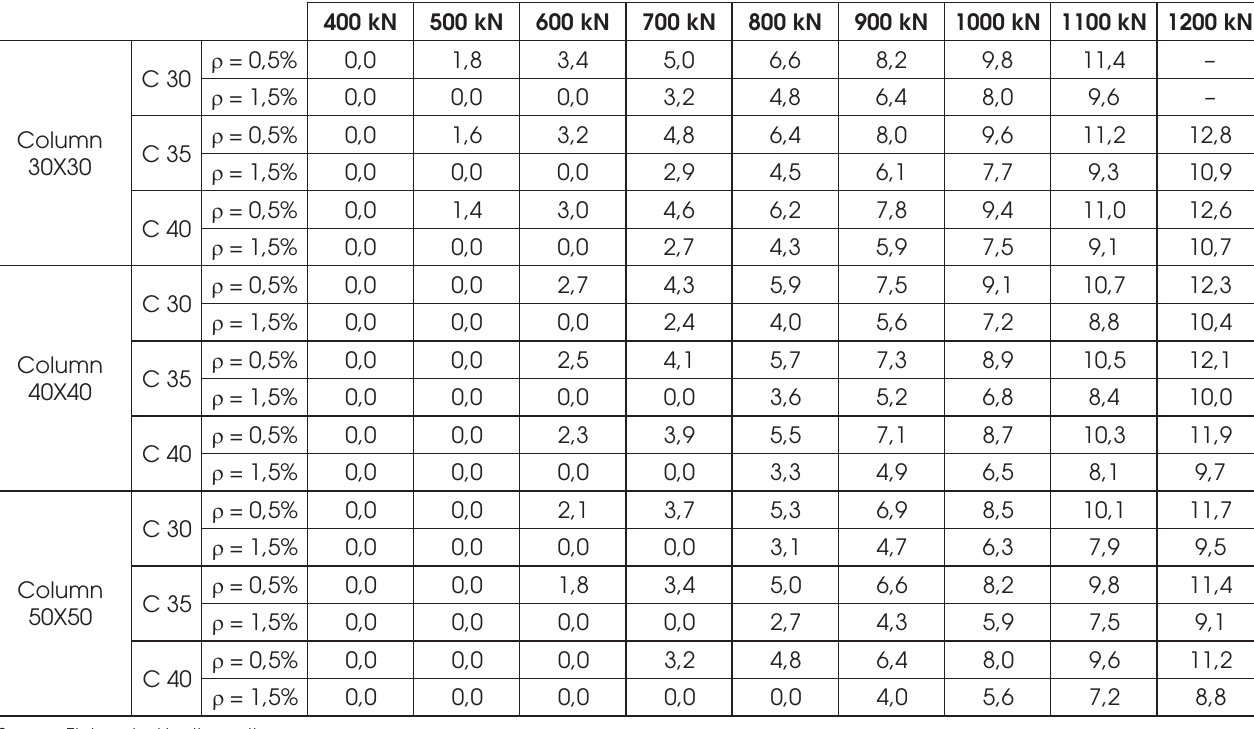
Area of shear reinforcement (cm²) by NBR 6118:2014 (analysis